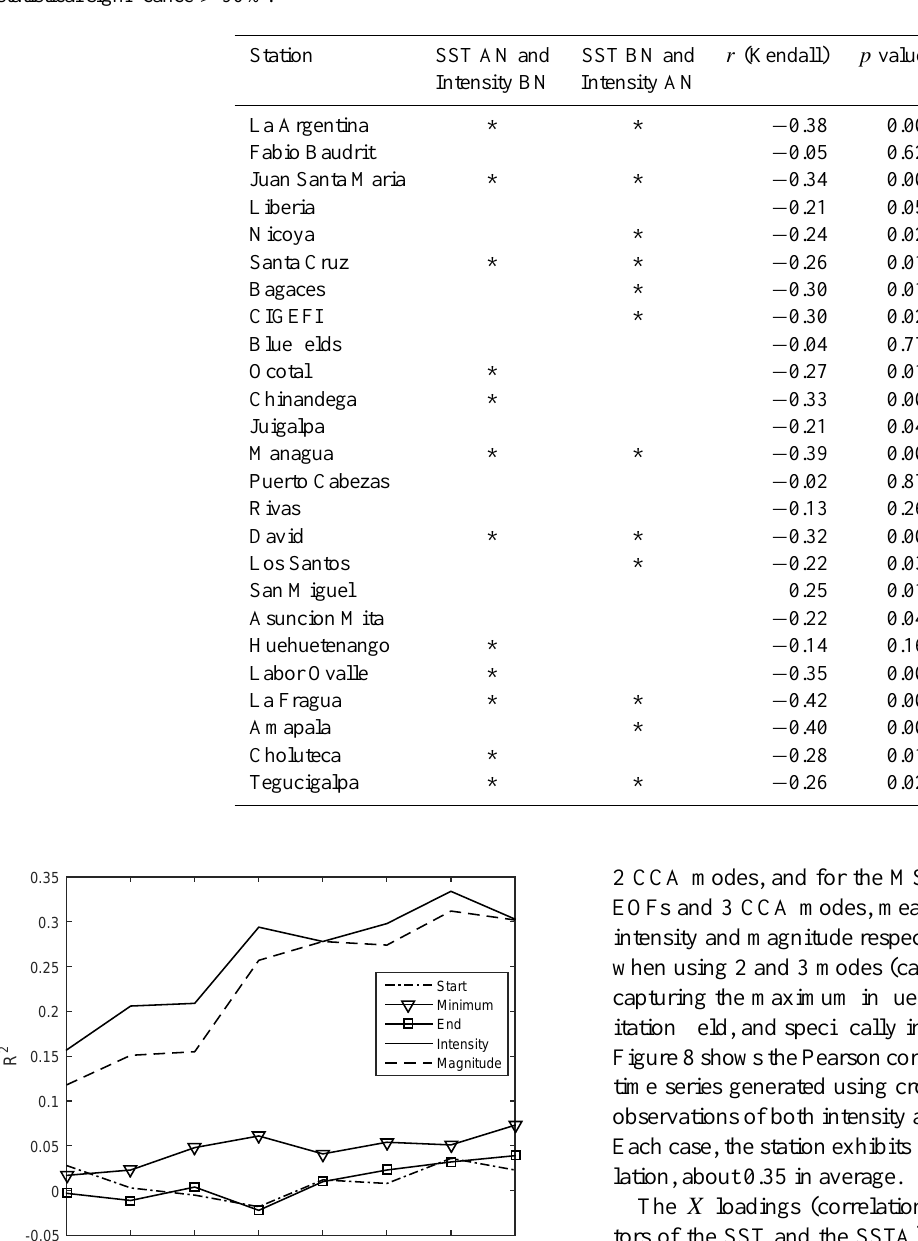
Table 2. Summary of contingency tables for each station. The tables were estimated using Niño 3.4 index and the mean intensity per year. The categories were defined using the 33rd (below normal, BN) and 67th (above normal, AN). Years in which the algorithm failed detecting any of the phases of the MSD, were removed. The star (*) represents cases in which the observed condition in column 2 or 3 dominates, and has statistical significance > 90%.